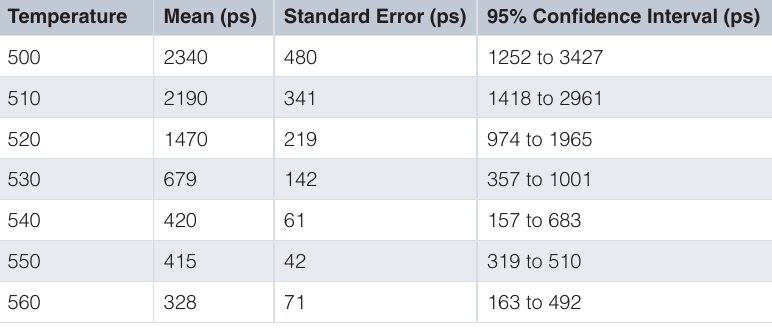
Table 1. Times until the loss of the bend from residue 36-38 in the protein in picoseconds.